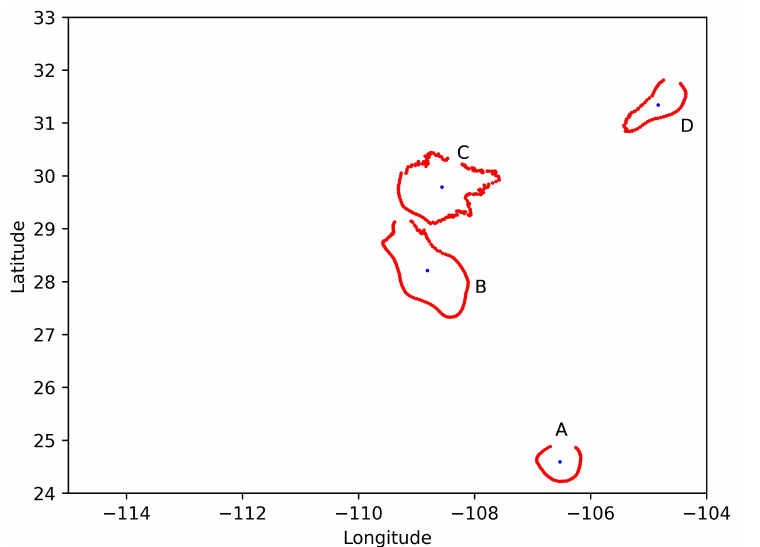
Figure 3. An example of MCS classification according to their eccentricity ( (cid:101) ). Event A ( (cid:101) > 0.7) and events B, C, and D ( (cid:101) < 0.7) correspond to the category MCC and PECSs,